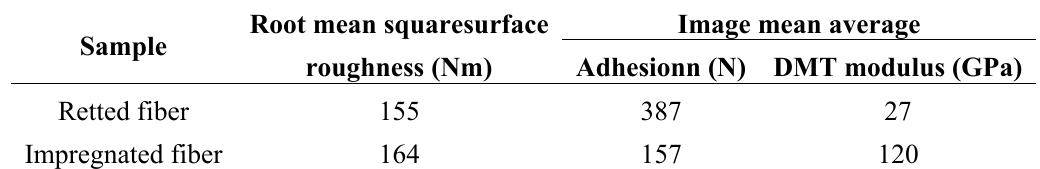
Table 4. Root mean square surface roughness, image mean average adhesion and Derjaguin-Müller-Toporon (DMT) Young’s modulus of INI kenaf bast fibers with chemically retted fibers used as